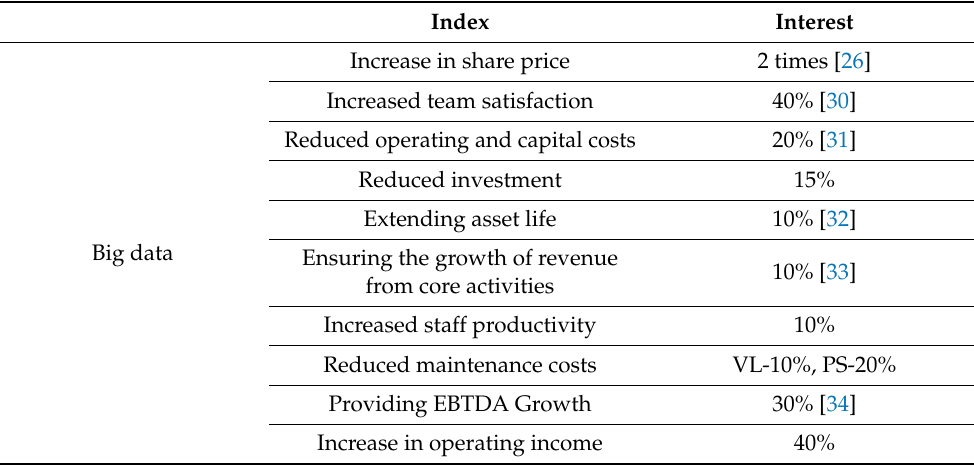
Table 2. Economic effect of using big data in energy (developed by the